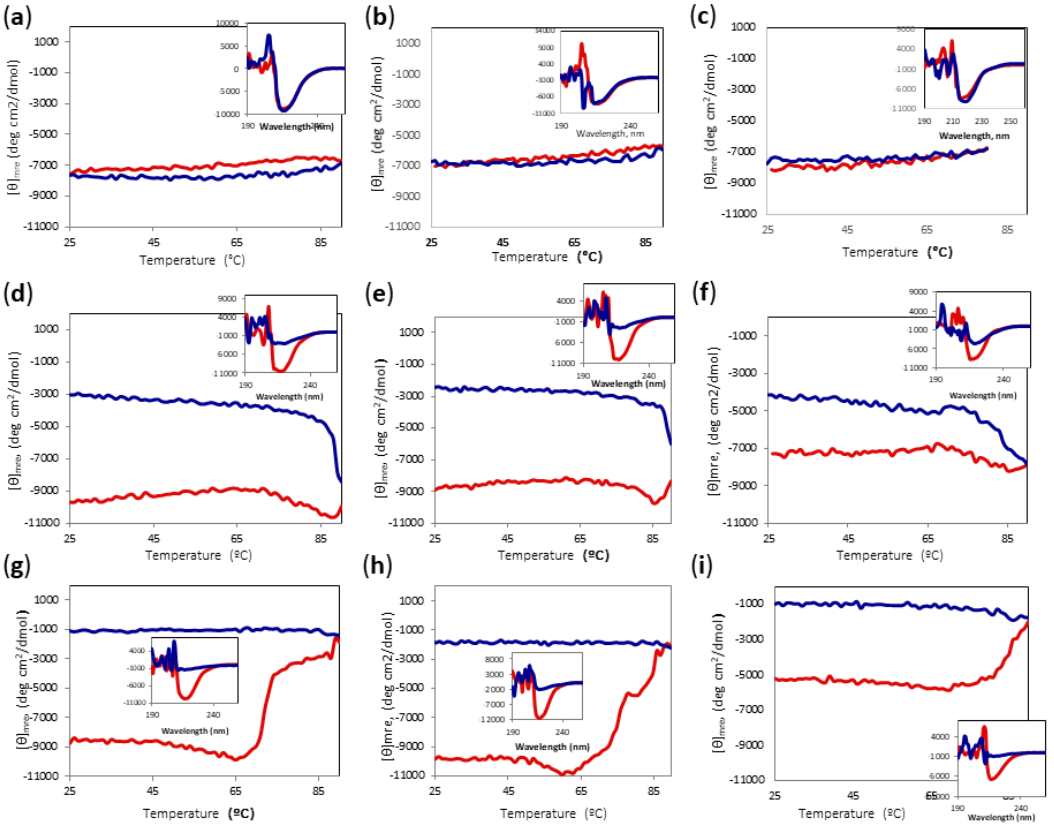
Figure 6. CD temperature scans of Amy A from 25 °C to 90 °C in different choline chloride:urea (1:2) DES and MeOH concentrations. Main chart: Amy A heating signal (red) and cooling signal (blue) at 220 nm. Inset: Far UV-CD spectra before heating (red) and after cooling (blue). ( a ) 60% DES; ( b ) 70% DES; ( c ) 80% DES; ( d ) 60% DES, 10% MeOH; ( e ) 70% DES, 10% MeOH; ( f ) 80% DES, 10% MeOH; ( g ) 60% DES, 20% MeOH; ( h ) 70% DES, 20% MeOH; ( i ) 80% DES, 20% MeOH.